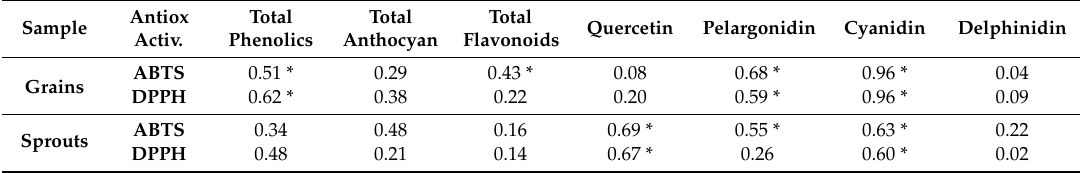
Table 1. Results of the correlation between antioxidant activity and contents of bioactive phytochemicals in grains and sprouts of colored wheat genotypes. Antiox Sample Activ.